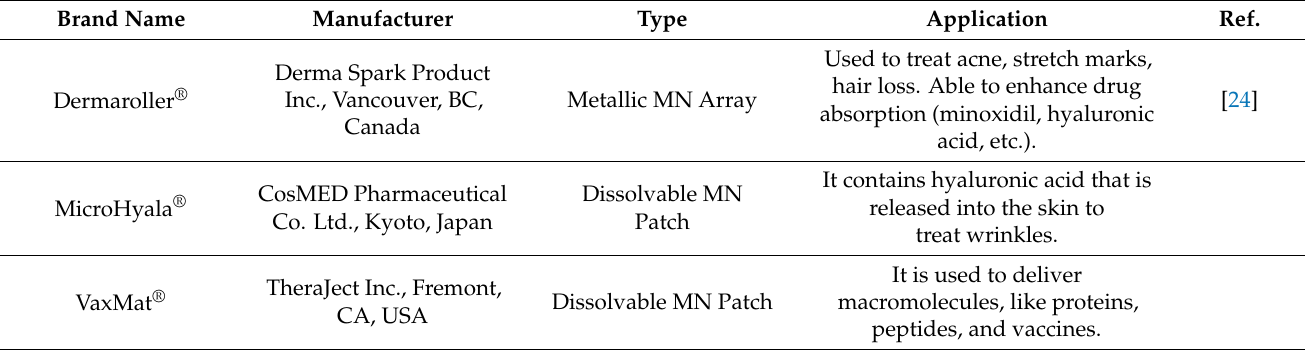
Figure 2. Different types of microneedles ( a ) solid microneedles use poke with patch approach, are used for pre-treatment of the skin; ( b ) coated microneedles use a coat and poke approach, a coating of drug solution is applied on the needle surface; ( c ) dissolving microneedles are made of biodegradable polymers; ( d ) hollow microneedles are filled with the drug solution and deposit the drug in the dermis. Reproduced with permission from [23], copyright Elsevier 2019. Table 1. Marketed microneedle-based transdermal products. 1